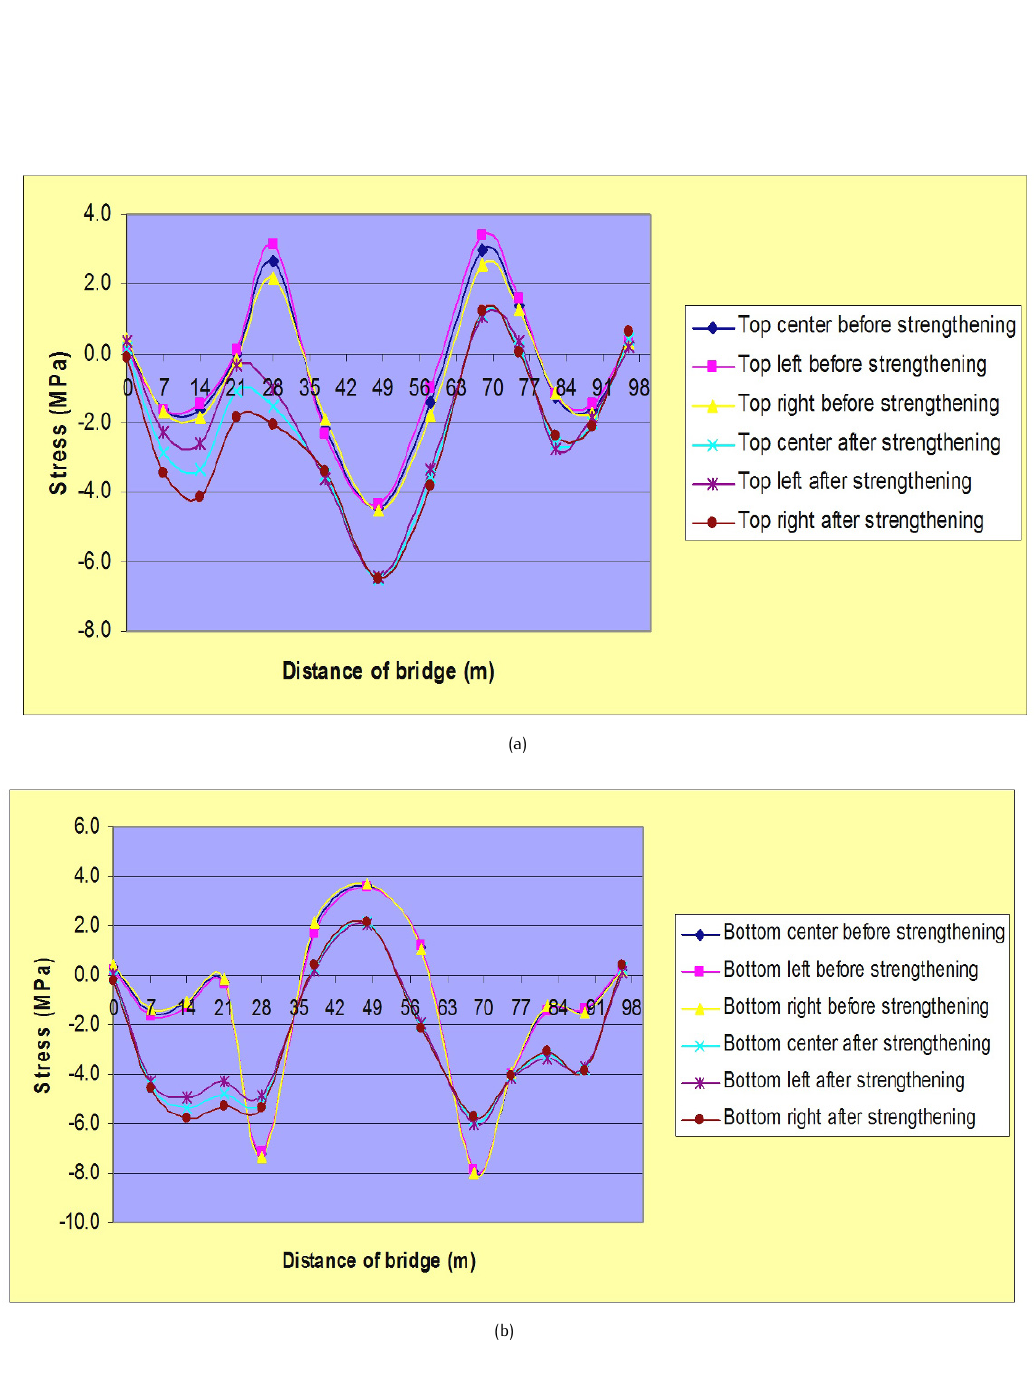
Figure 13. The values of stresses before and after strengthening due to load combination II for object No.2, (a) Max. top value of box girder, (b) Max. bottom value of box girder